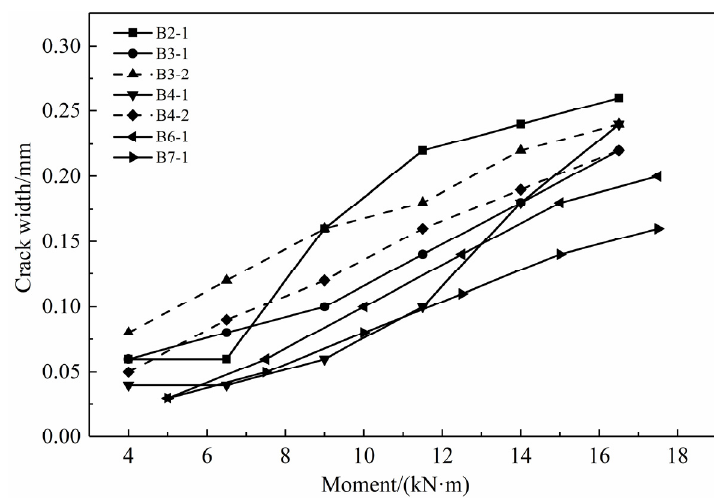
Figure 8. Comparison of average crack interval between NC and RASCC beams.